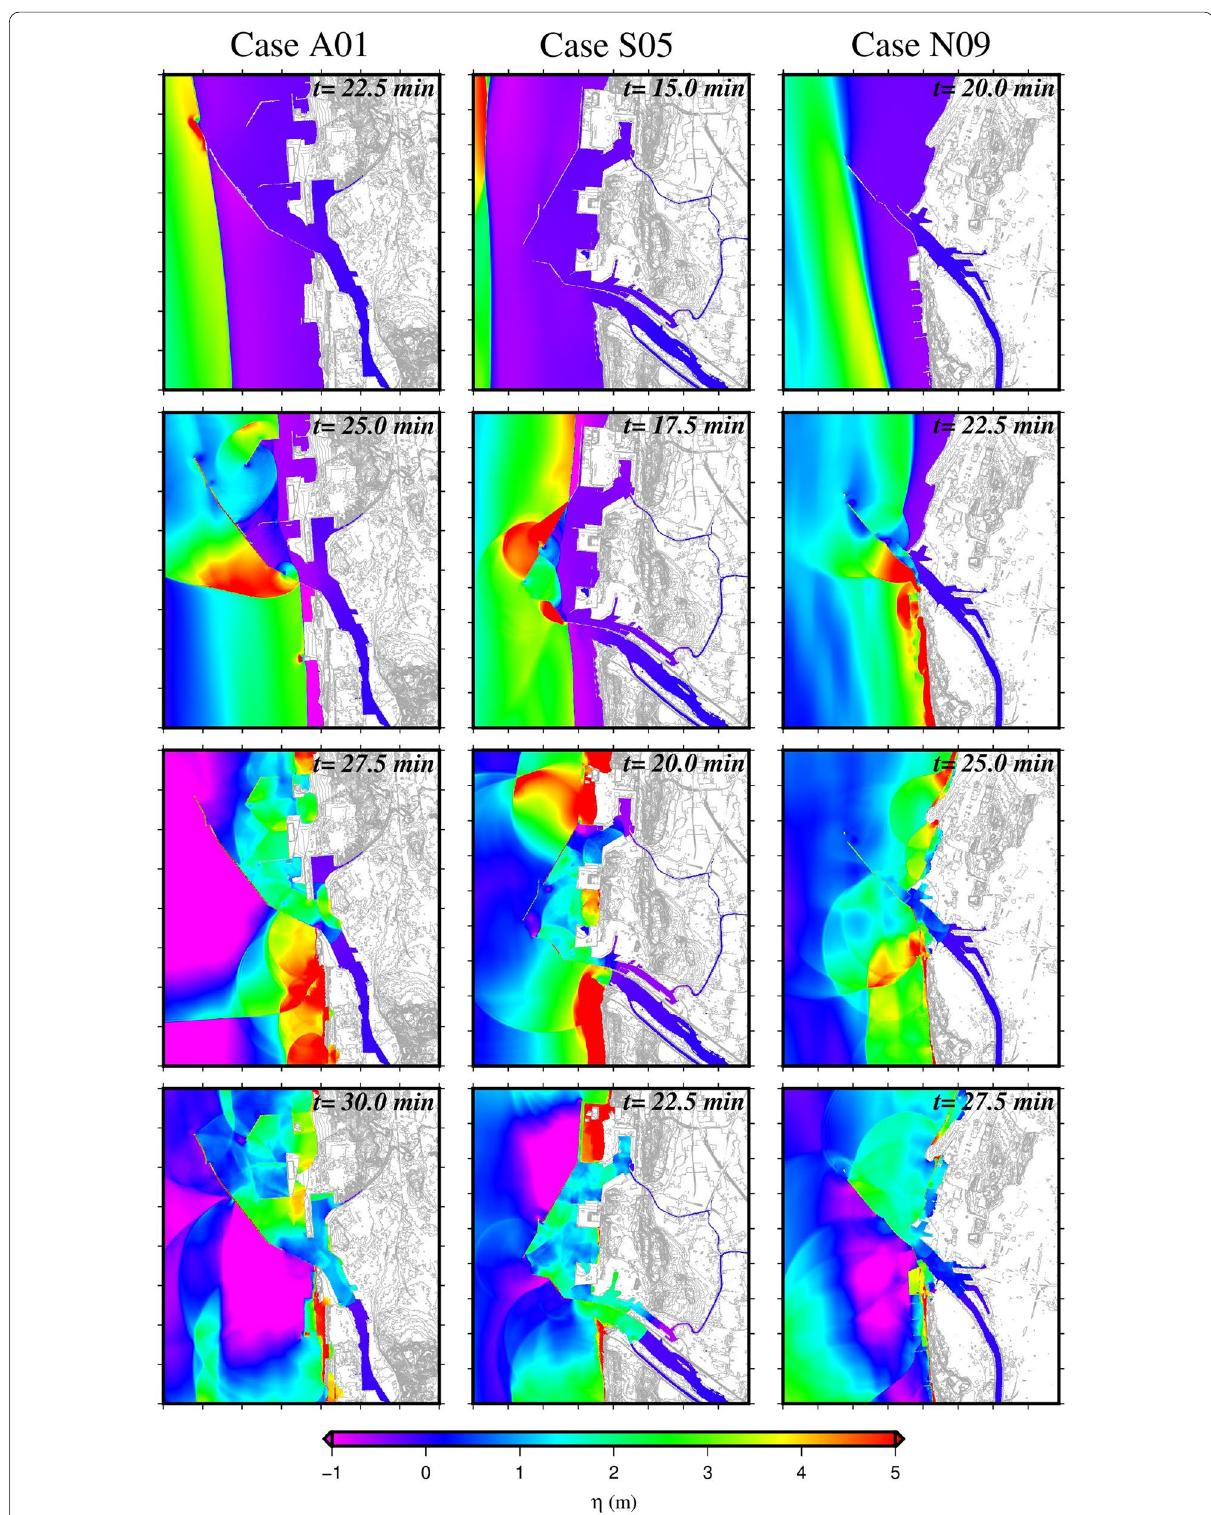
Fig. 7 Snapshots of representative nearshore tsunami propagations. The left, middle, and right panels correspond to the time series for Akita City, Sakata City, and Niigata City, respectively. The displayed areas correspond to the areas specified by the blue squares in the top-right, middle-right, and bottom-right panels in Fig. 3; the thick interval was 1